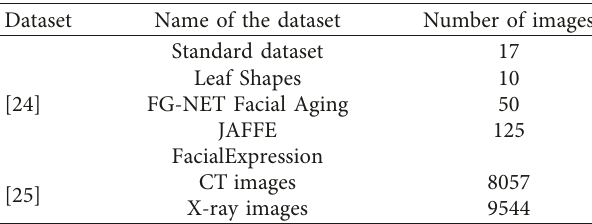
Table 1: Dataset description.